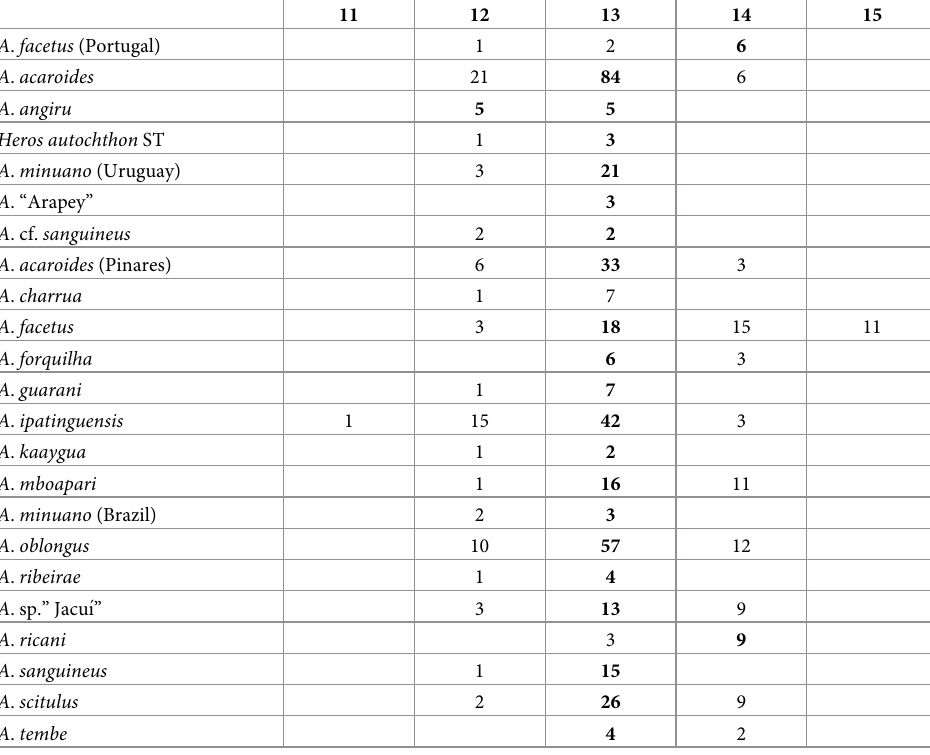
Table 8. Number of pectoral-fin rays in species of Australoheros .